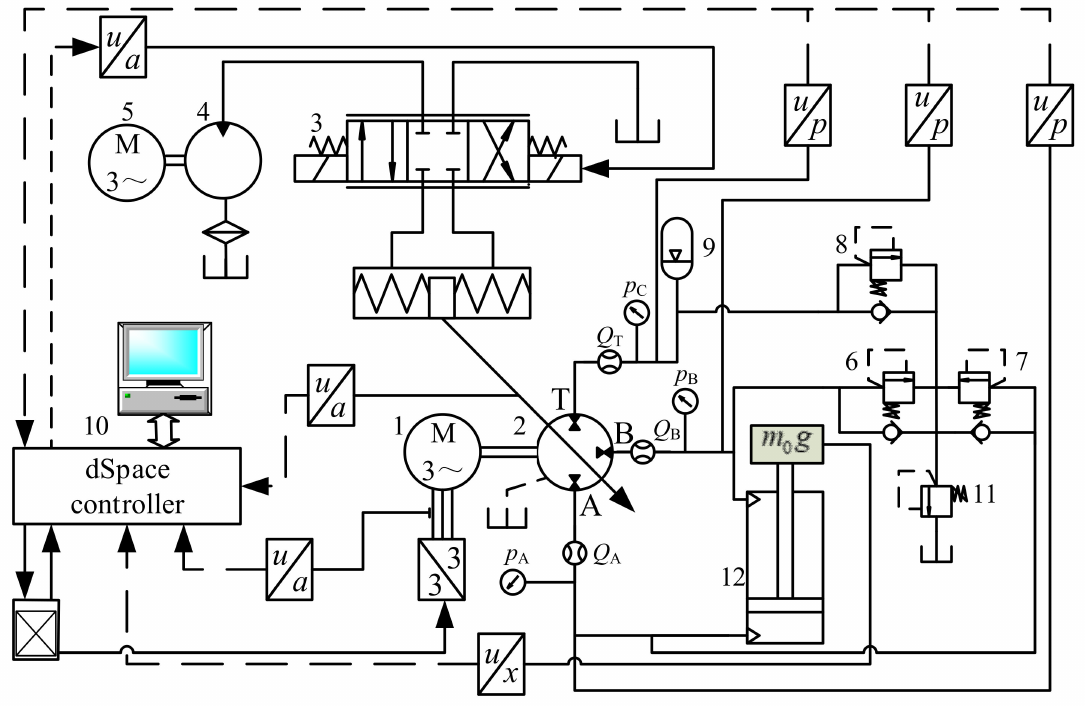
Figure 8. Principle of the test